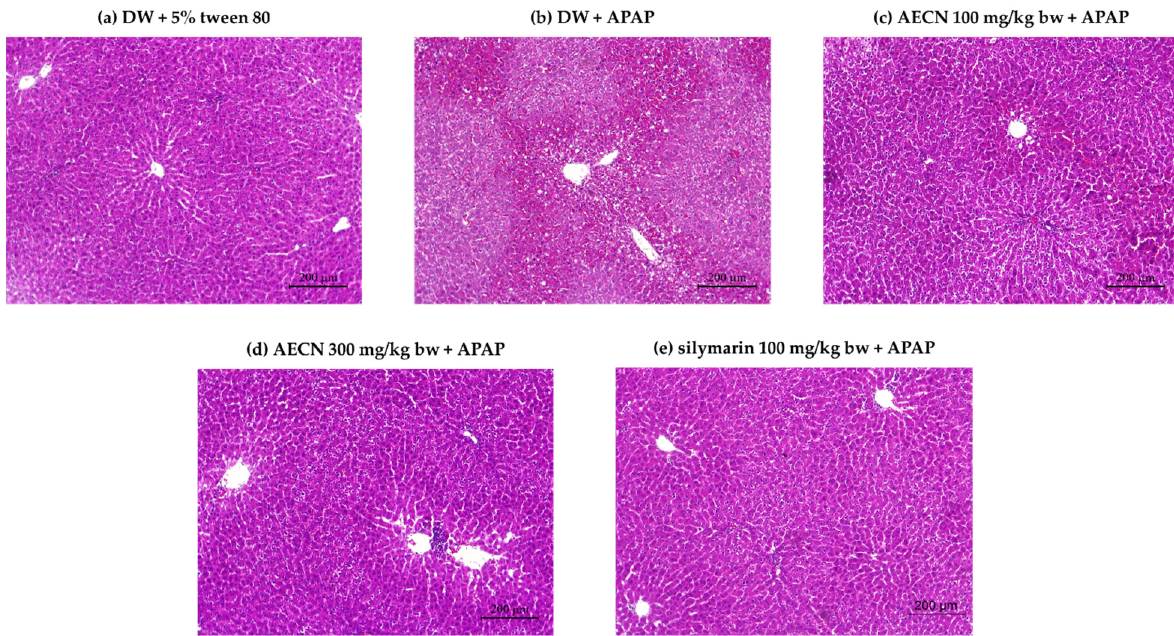
Figure 3. Histopathological analysis of liver sections of rats (10×). DW + 5% tween 80 ( a ), DW +